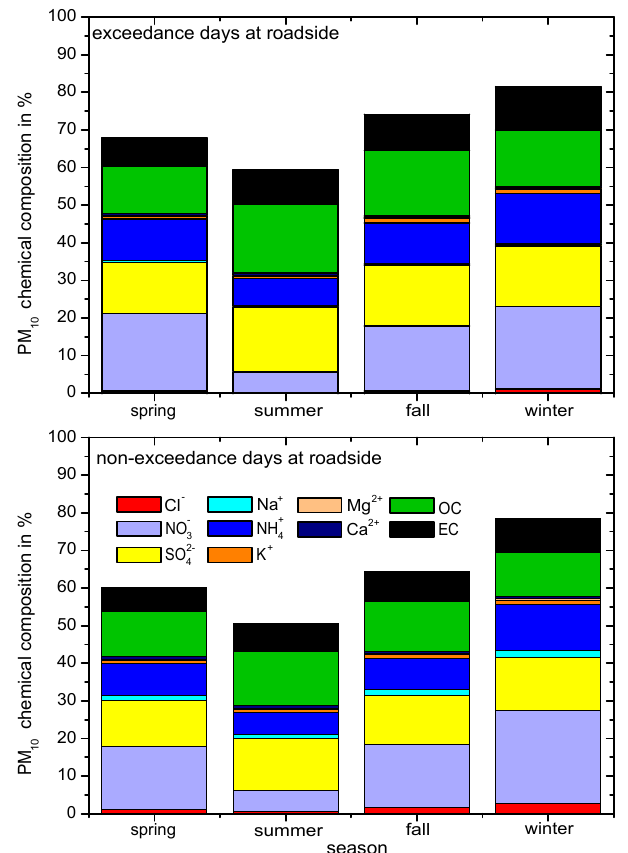
Fig. 7. Chemical mass fractions of rural background PM 10 for each season and (a) exceedance days at roadside and (b) non-exceedance days at roadside. The gap between the total amounts shown and 100% is material not accessible to the analytical procedures; this is interpreted as insoluble crustal